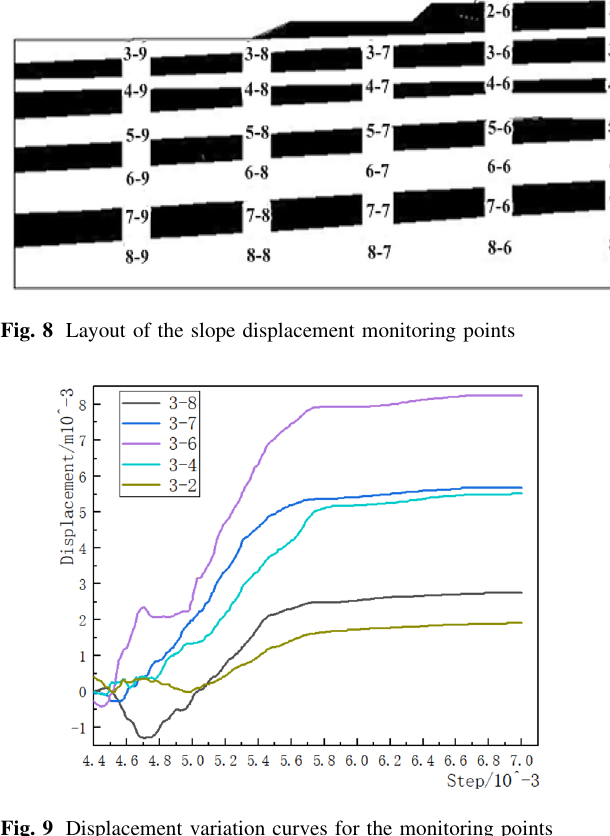
Fig. 9 Displacement variation curves for the monitoring points